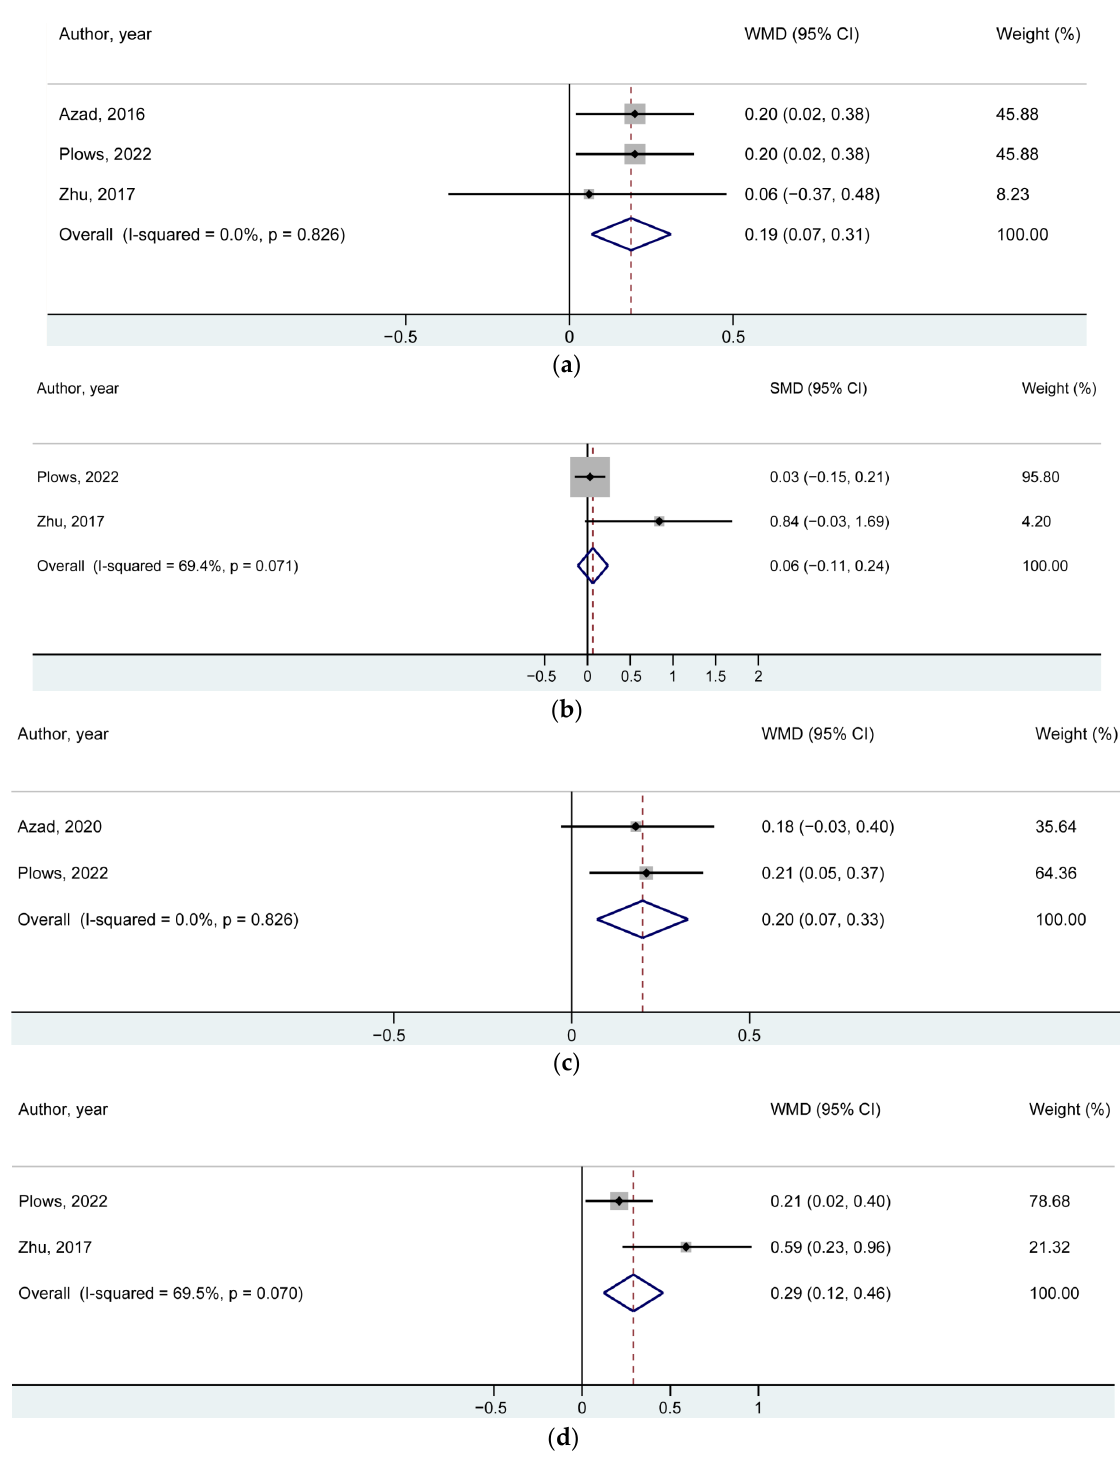
Figure 2. Forest plots for the relationship between NNS during pregnancy and BMI z-scores of offspring ( a ) for the outcome at 1 year of age; ( b ) for the outcome at birth; ( c ) for the outcome at early childhood; ( d ) for the outcome at mid-childhood; [6,7,15]. Table 2. Relation between NNS and BMI z-score in offspring.